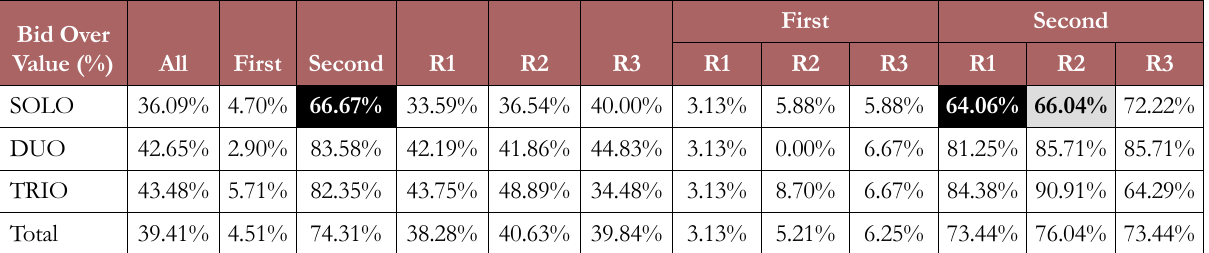
Table 4. Bid over value: pairwise differences in terms of size by right and